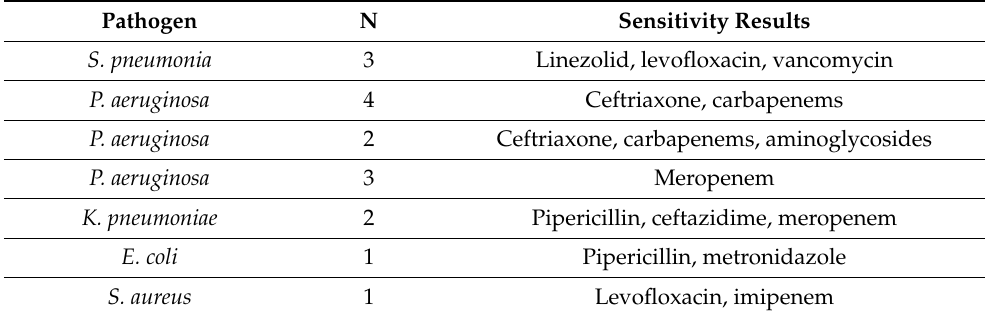
Table 7. Findings of culture and sensitivity testing. Pathogen N Sensitivity